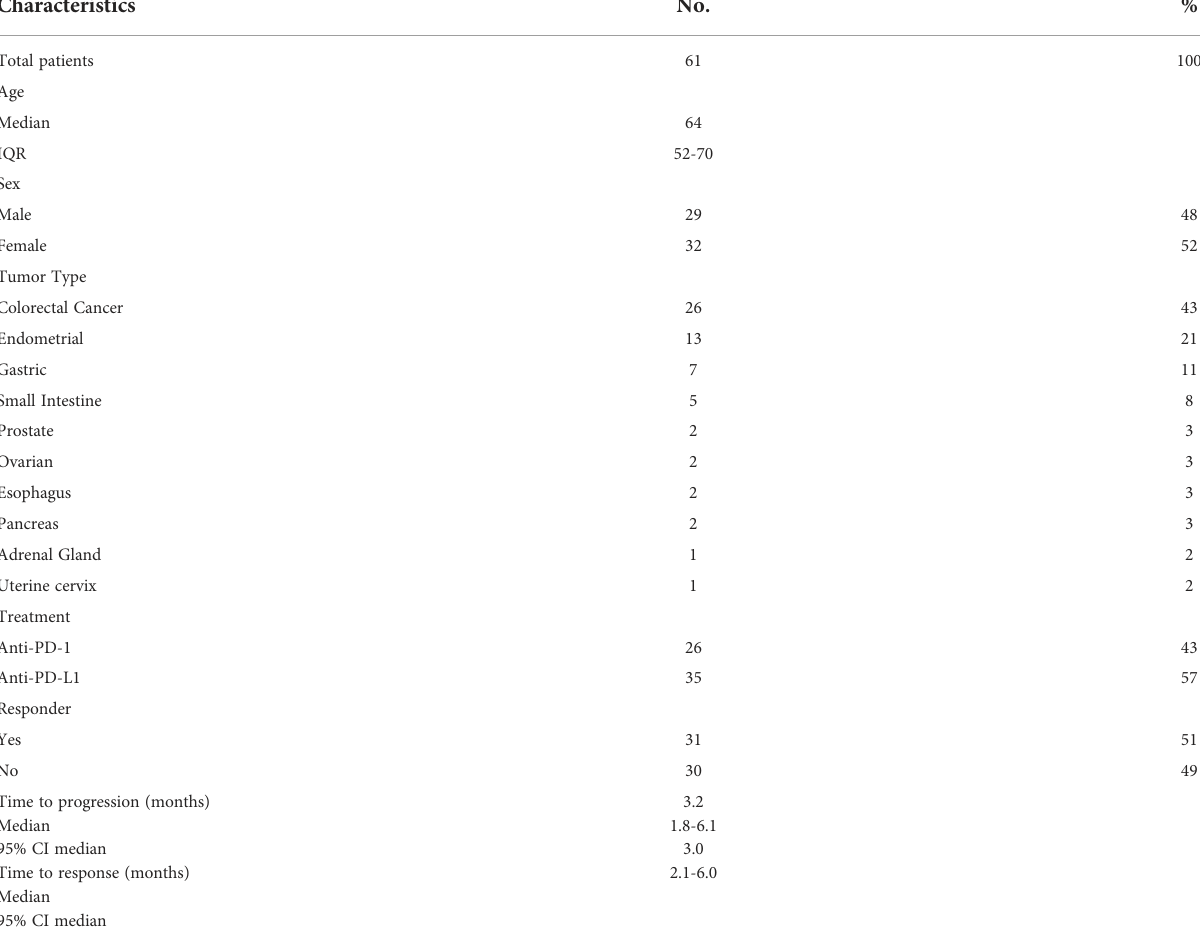
TABLE 1 Baseline patients ’